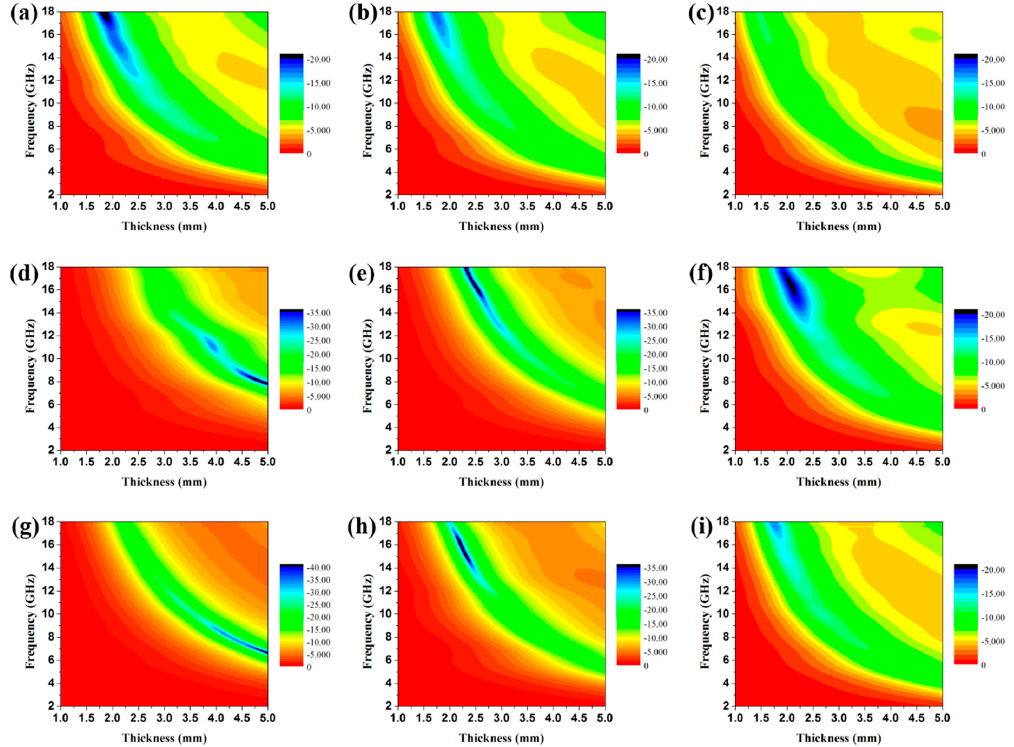
Figure 8. Contour maps of reflection loss of the paraffin composites containing ( a ) 15 wt %, ( b ) 20 wt %, and ( c ) 30 wt % Sample A; 15 wt % ( d ), 20 wt % ( e ) and 30 wt % ( f ) Sample B; ( g ) 15 wt %, ( h ) 20 wt %, and ( i ) 30 wt % Sample C.